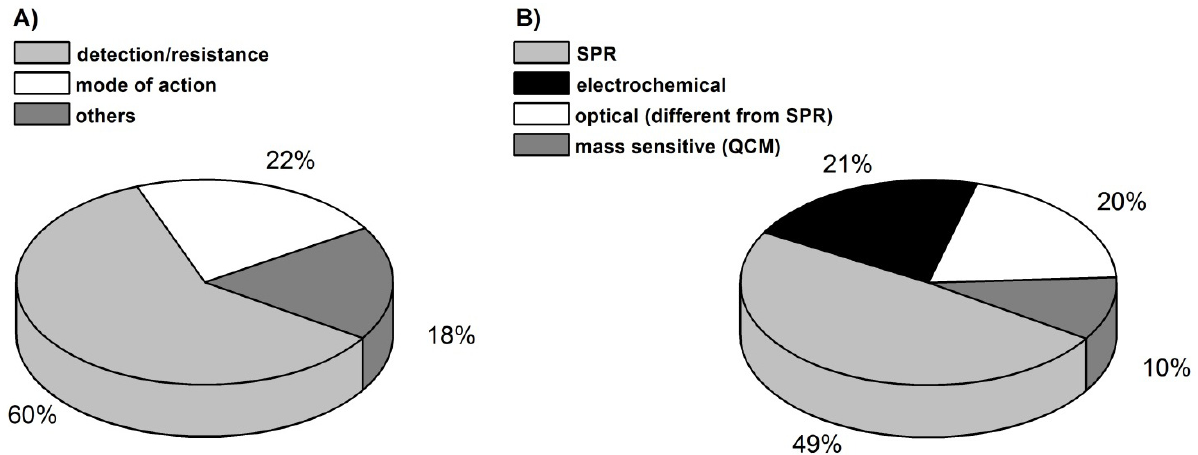
Figure 3. Biosensor applications in the antibacterial field are classified regarding to ( A ) their experimental approaches, and ( B ) the detection principles. (A) Nearly 60% of the biosensor applications contribute to detection or quantification of antibacterials in the environment as a basis for interference with the increasing bacterial resistance; (B) Nearly half of the detection principles are based on surface plasmon resonance